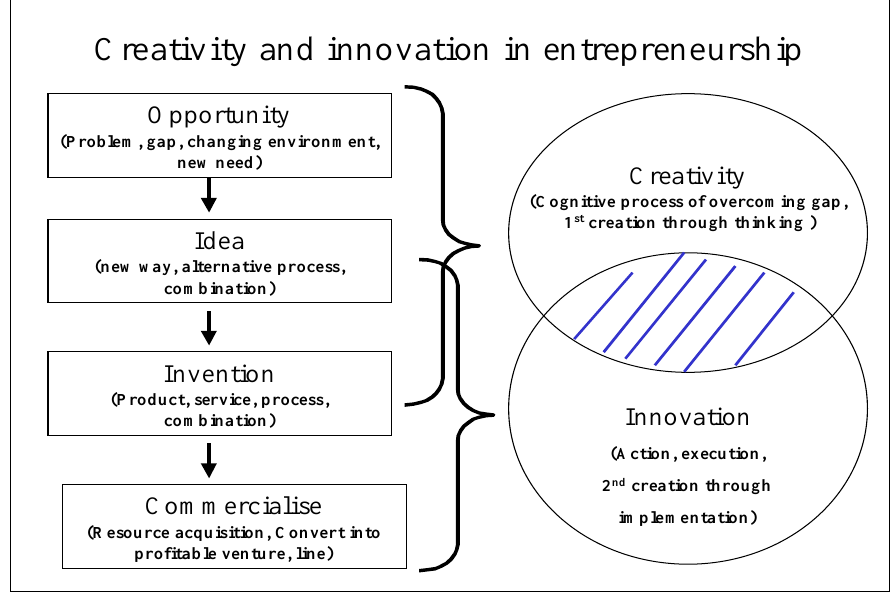
Figure 1: The relation between creativity and innovation indicating the inclusive and distinctive domains between the constructs in entrepreneurship (Own